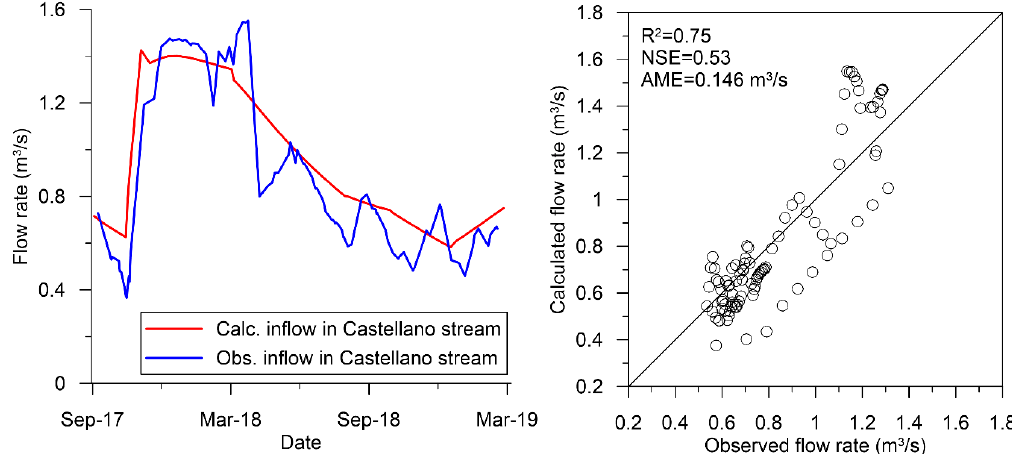
Figure 8. Calculated and observed inflow from the aquifer towards the Castellano stretch, as time series (left panel) and scatter diagram (right panel).